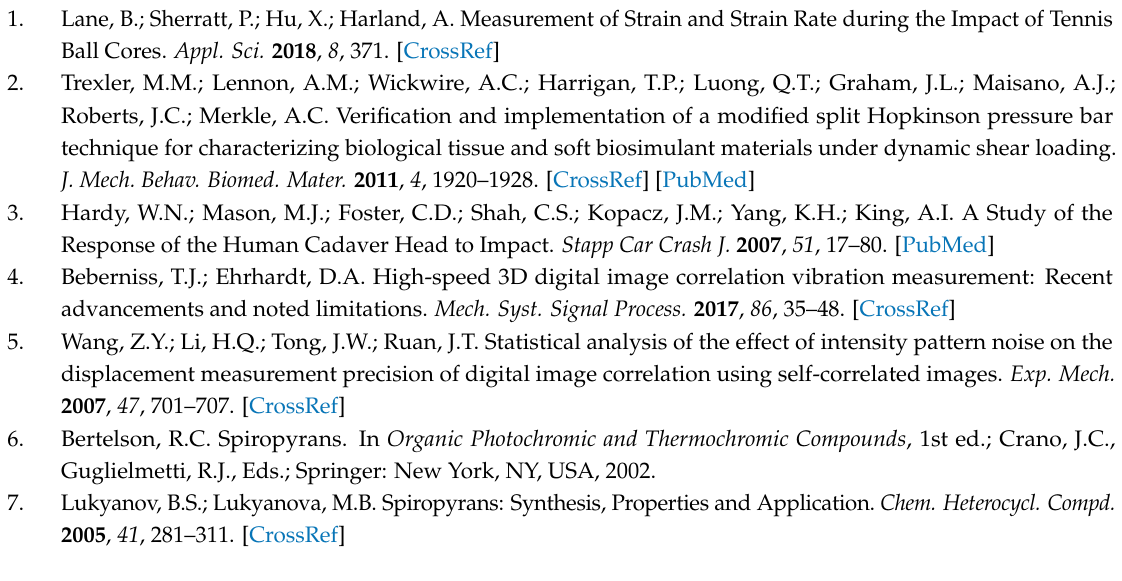
Supplementary Materials: The following are available online, Video S1: Comparison between high speed impact (left) and finite element analysis